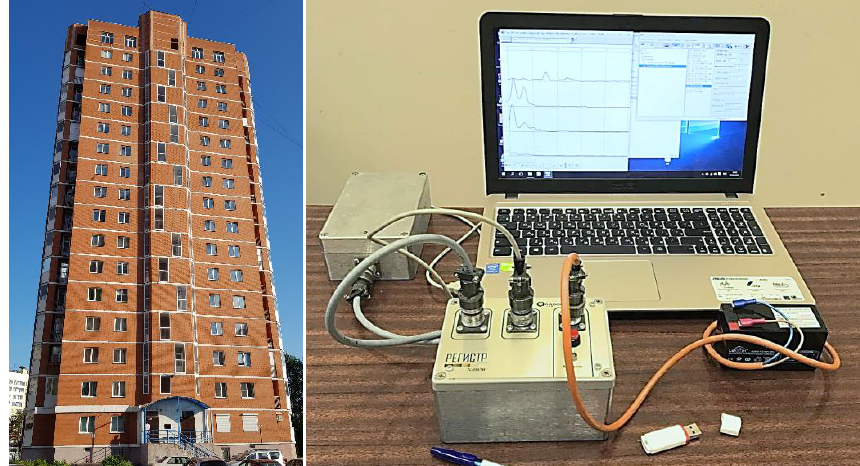
Fig. 1. Analysed multi-storey residential building and tree component seismic complex